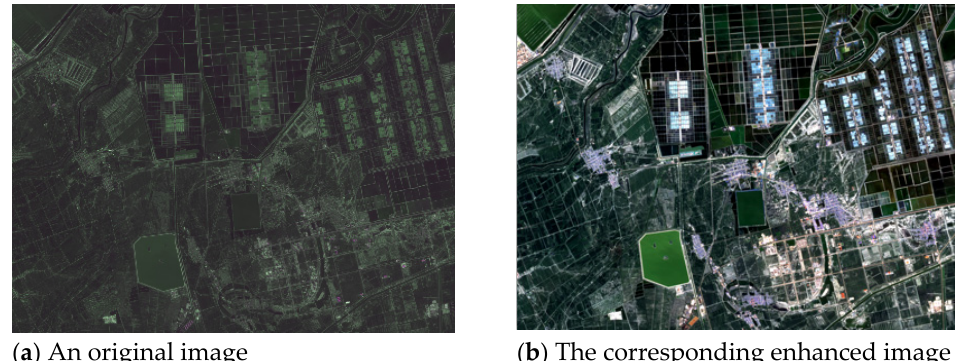
Figure 2. Stretching of a pseudo-color image synthetized from a GF-1 (Gaofen-1) multispectral image, acquired at 38 ° N and 117.7 ° E on September 9, 2014: ( a ) An original image; ( b ) the corresponding enhanced image.